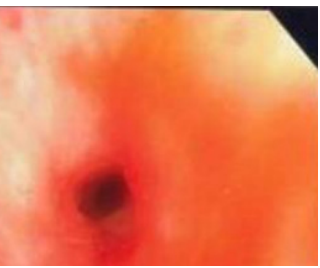
Figure 2. Oedematous hyperaemic lesion. Type 2 Endobronchial TB.